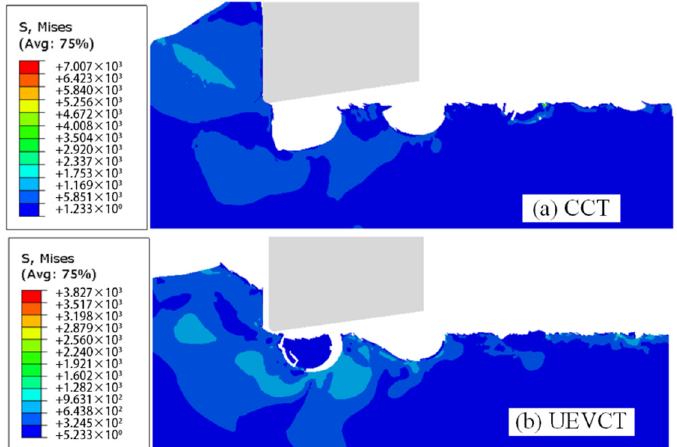
Figure 5. Comparison of overall surface morphology in cutting process. ( a ) Conventional cutting shape; ( b ) Ultrasonic elliptical vibration cutting shape.